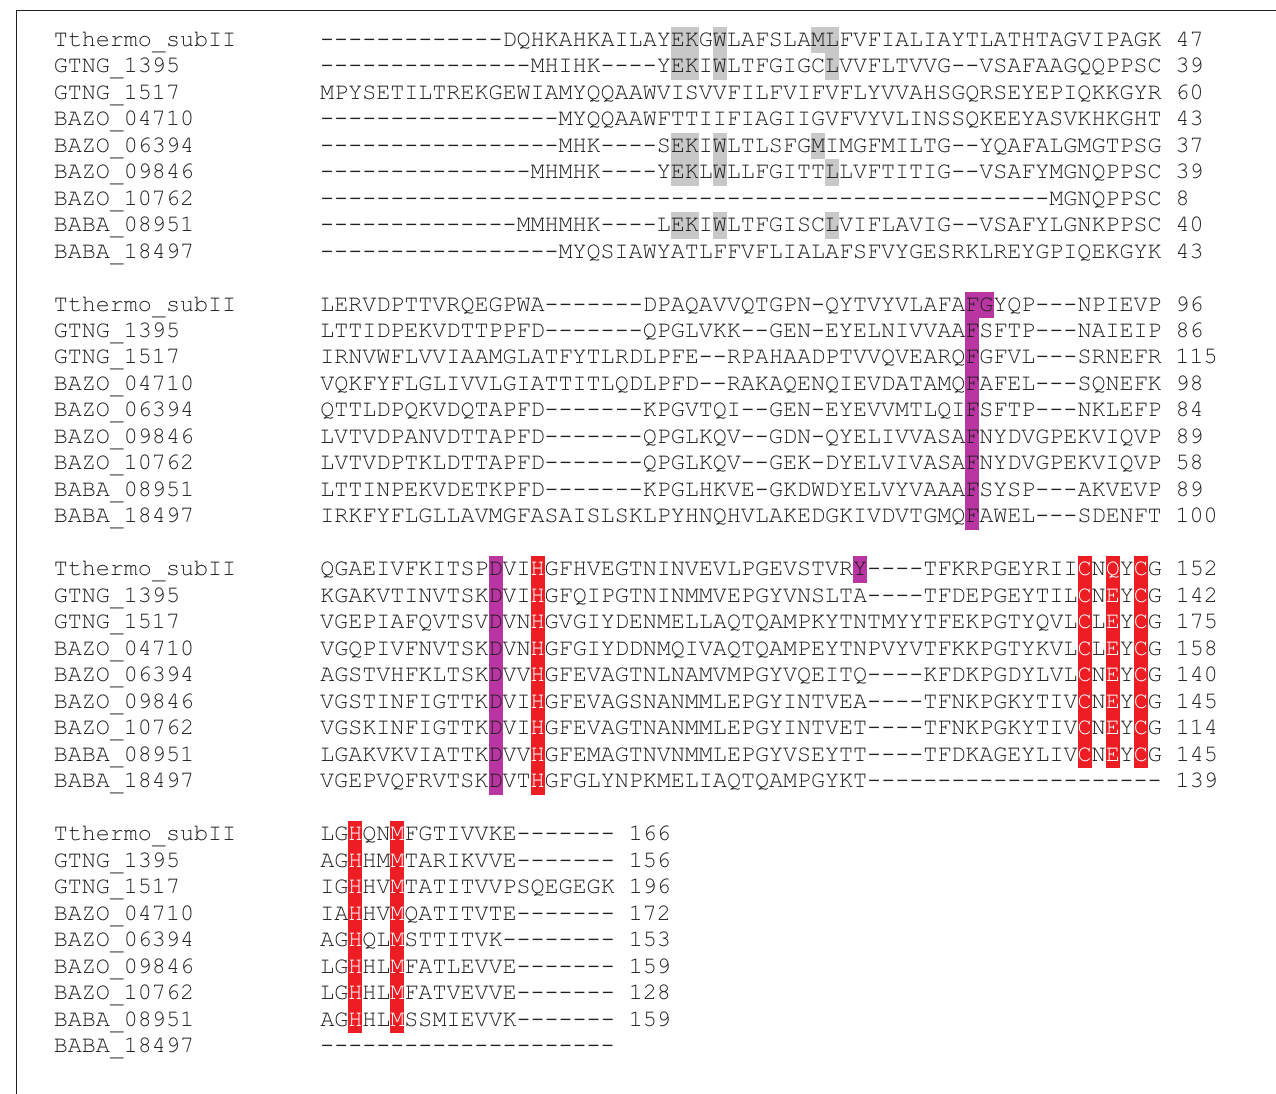
T. thermophilus (PDB 3EH3). Contact site residues are highlighted in gray, residues for Cu A -binding in red, and residues for electron transport in pink. PDB, protein database accession